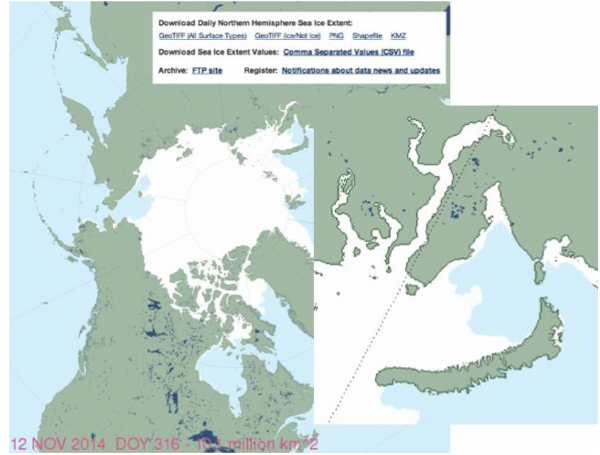
Figure 3. Sample MASIE product (with zoomed Kara Sea region inset on right) valid on 12 November 2014. White indicates ice- covered